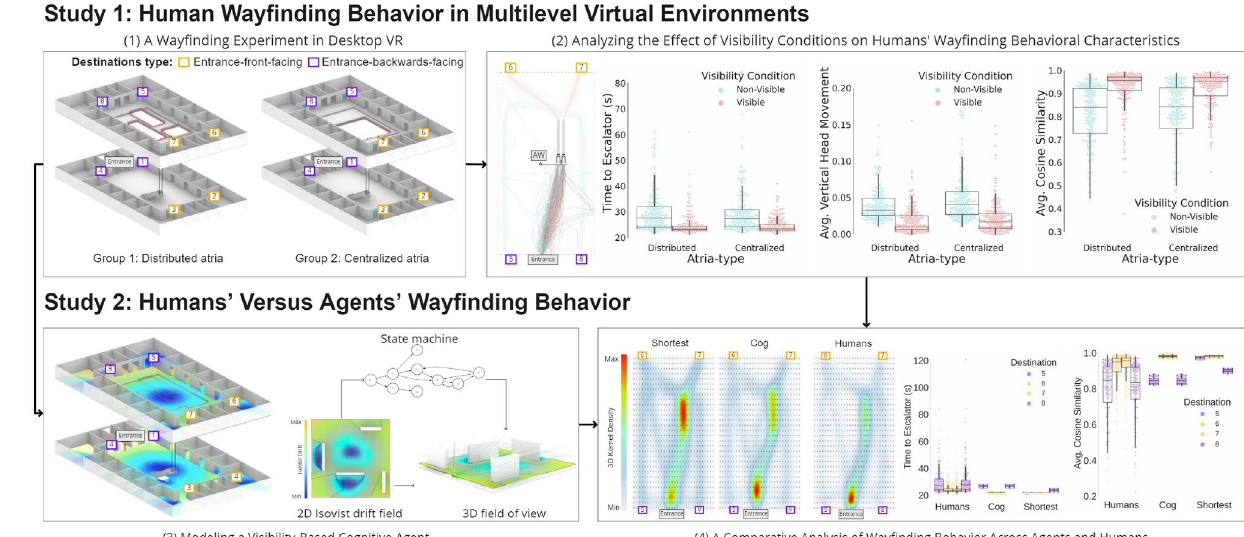
Figure 1. An overview of the research design and the links between the different research stages; Study 1 includes two stages: (1) A wayfinding experiment in desktop VR under two systematically varied multilevel environments and (2) An analysis of the experiments ’ results to quantify the effects of visibility on wayfinding behavioral characteristics. On the basis of this analysis, we conducted study 2 that included two additional research stages: (3) Modeling of a visibility-based cognitive agent that aims to capture observed human wayfinding behavior and finally stage (4) A comparative analysis that analyzed the similarity between agents ’ and humans ’ wayfinding behavior in respective environments (i.e., distributed versus centralized atria-type). Software used to create this figure: Python 34 (version 3.5.8), https:// www. python. org/ downl oads/ relea se/